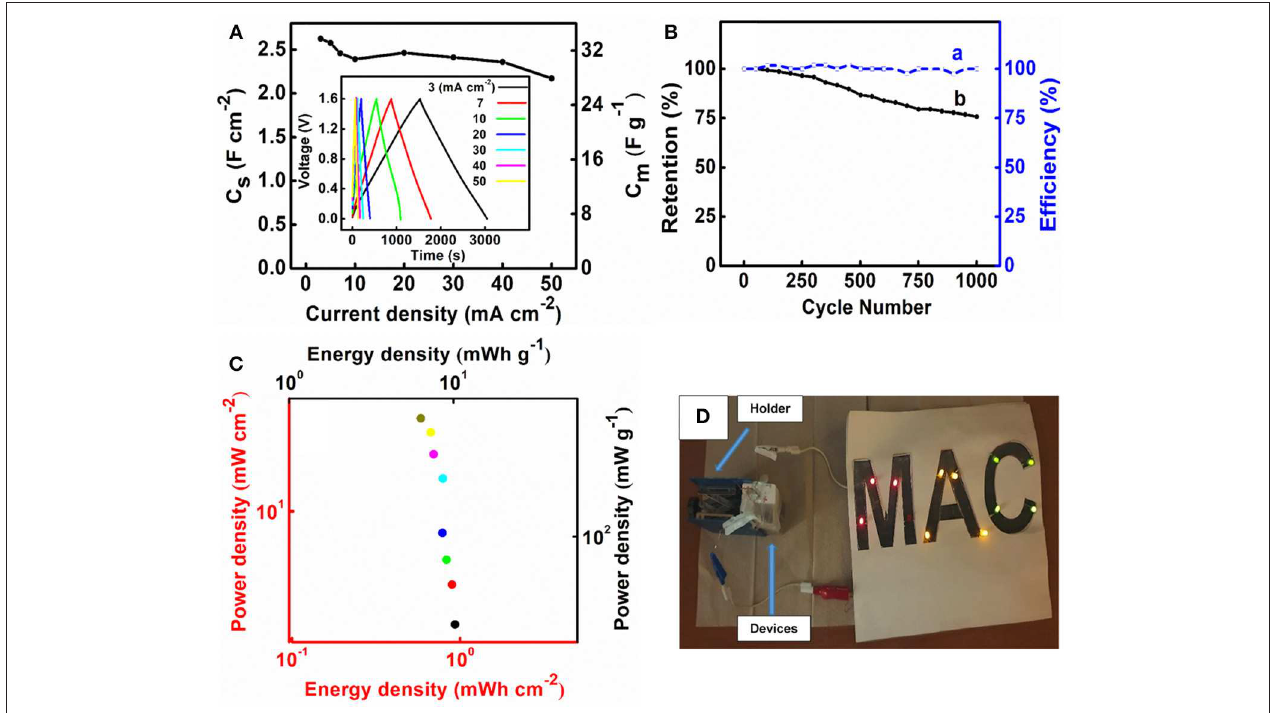
FIGURE 9 | (A) C S and C m vs. current density calculated from discharge data, inset shows charge-discharge curves, and different current densities, (B) (a) Coulombic efficiency and (b) capacitance retention and vs. cycle number, (C) Ragone plot for an asymmetric supercapacitor cell, containing M-FH-CB-MWCNT as a negative electrode and MnO 2 -MWCNT as a positive electrode, (D) LEDs powered by two asymmetric cells.